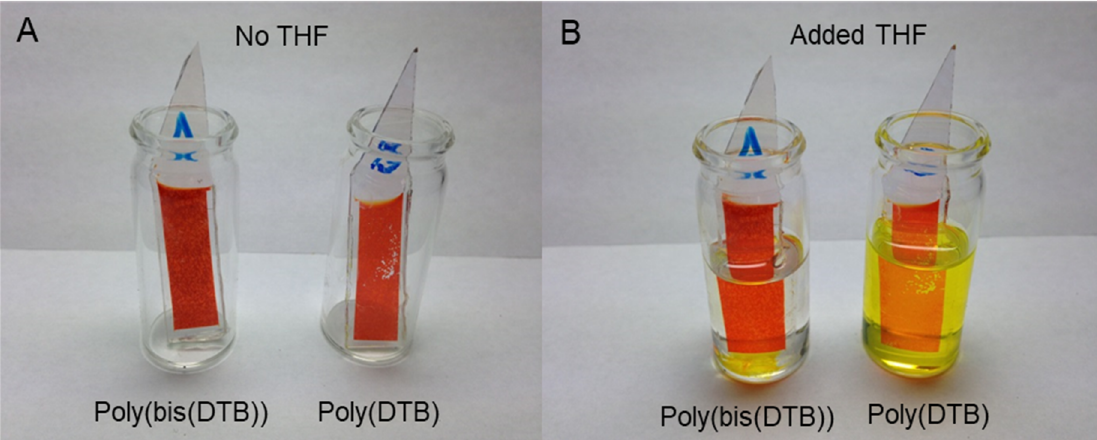
Figure 8. Solvent resistance of poly(DTB) and poly(bis(DTB)) to THF. ( A ) Before addition of THF; ( B ) after addition of THF.